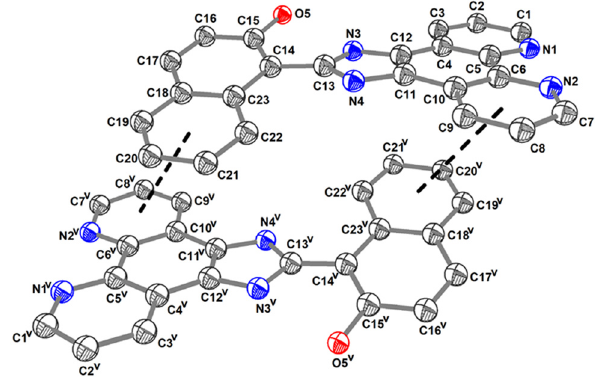
Figure 4: View of the π – π interactions between two L ligands of neighboring layers ( symmetric code: ( v ) – x , – y + 1, – z + 1 ) .